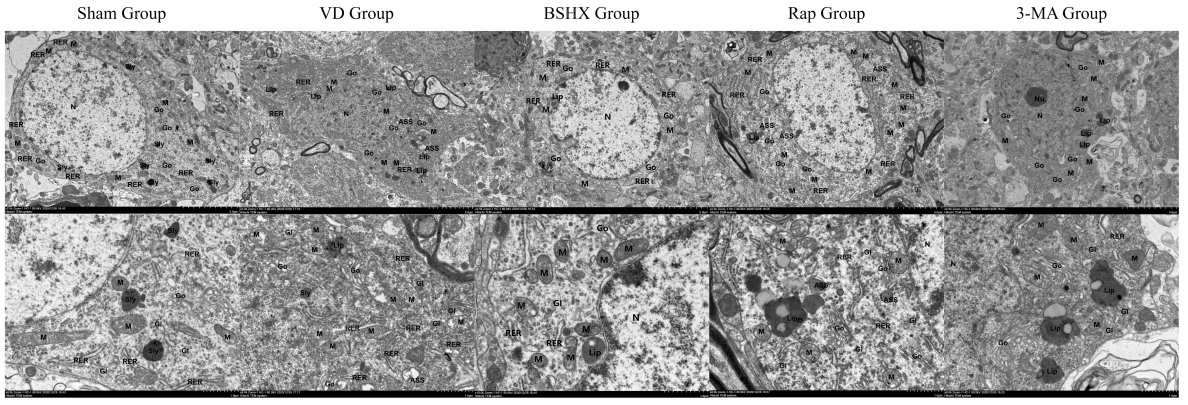
Fig. 8. Neuronal damage and autophagy in the hippocampal CA1 region of rats in each group were observed by TEM. Each group had two views, one at low power (2500 × ), and the other at high power (6000 × ). In the Sham group, the nuclei (N) were large and round, with abundant organelles, slightly damaged mitochondria(M), abundant secondary lysosomes (SLy). Rough endoplasmic reticulum (RER) was slightly dilated, surface ribosomes were degranulated, Golgi bodies (GO) were abundant, and glycogen (Gl) was evenly dispersed in the cells. No autophagy was observed in the cells (0). In the VD group,thenucleiwereabnormal,thecellswereirregular,therewasmorelipofuscin(Lip)andsecondarylysosomeaccumulationinthecells,mitochondriawere slightly vacuolated, and autophagic lysosomes (ASS) were observed intracellular (2). In the BSHX group, the nuclei were large and translucent, with abundant organelles, moderate mitochondrial edema, and no autophagy was observed (0). The RAP group had abnormal nuclei, irregular cells, more lipofuscin in cells, slight mitochondrial vacuolation, and more autophagy (3). In the 3-MA group, the nuclei were abnormal, and the cell body was slightly irregular. There was a certain amount of lipofuscin and a small number of secondary lysosomes in the cells. Mitochondria were slightly damaged, and no autophagy was observed